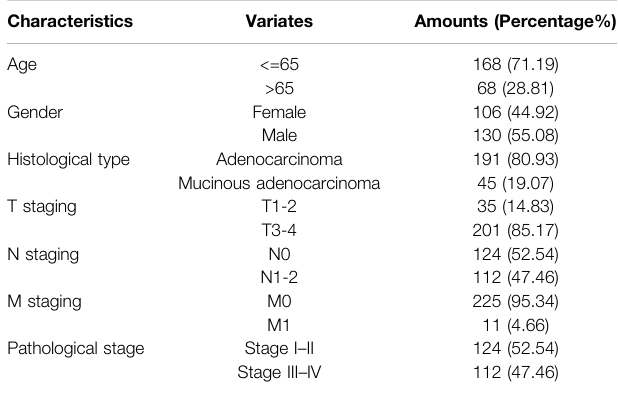
TABLE 1 | The overview of JLUFH CRC patients ’ clinical characteristics.